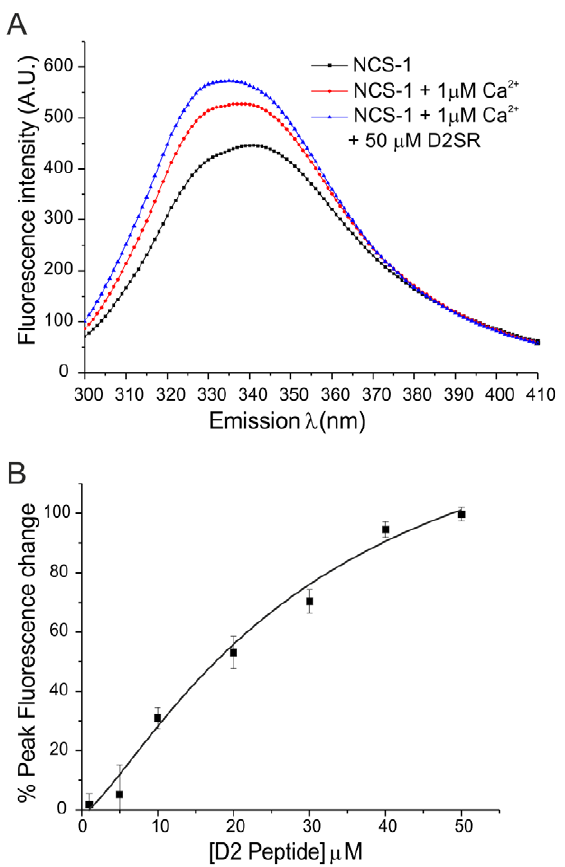
Figure 2. Binding of the dopamine D2 receptor C-terminus to NCS-1 monitored using tryptophan fluorescence. (A) The spectra represent intrinsic tryptophan fluorescence of NCS-1 before and after addition 1 m M Ca 2 + and after subsequent addition of the D2SR peptide. (B) Extent of the changes in tryptophan fluorescence following sequential additions of D2SR peptide to the final concentrations indicated. The data are shown as mean 6 SEM (n=5) and were fitted using a logistic fit by non-linear curve